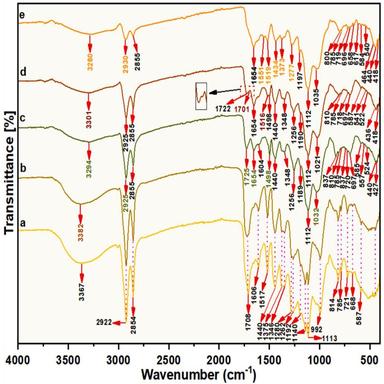
The FT-IR spectra of (a) the pure Sp, (b) the act. Sp, (c) Sp-T, (d) Sp-TA and (e) the fluorescent Sp-TAB hybrid material.